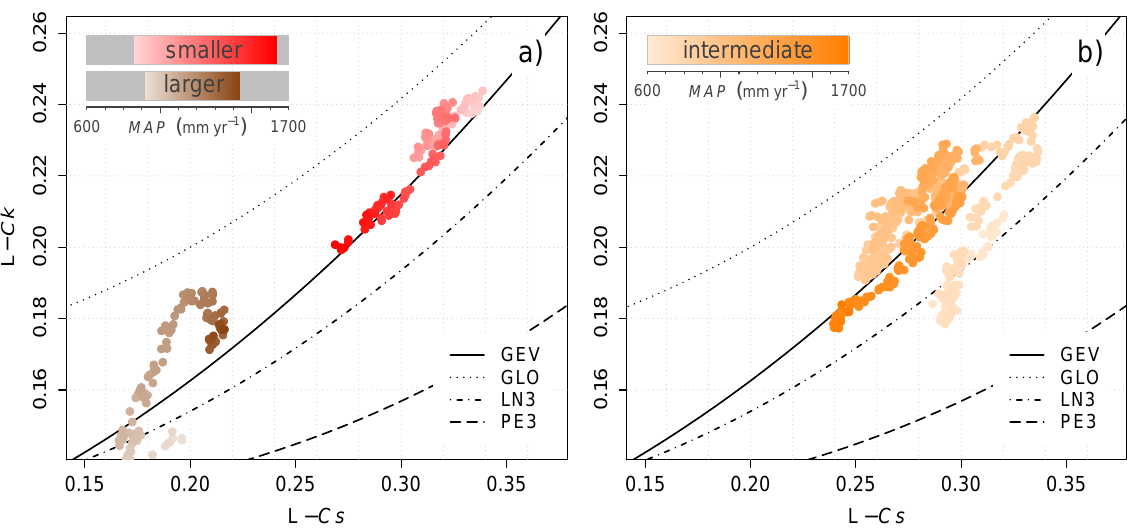
Figure 5. L-moment ratio diagrams for the subsets defined by catchment area: (a) smaller, larger, and (b) intermediate described in Fig. 3. Each point represents the record length WMA over 70 catchments of L-Ck against corresponding values of L-Cs and the colour intensity is proportional to MAP.